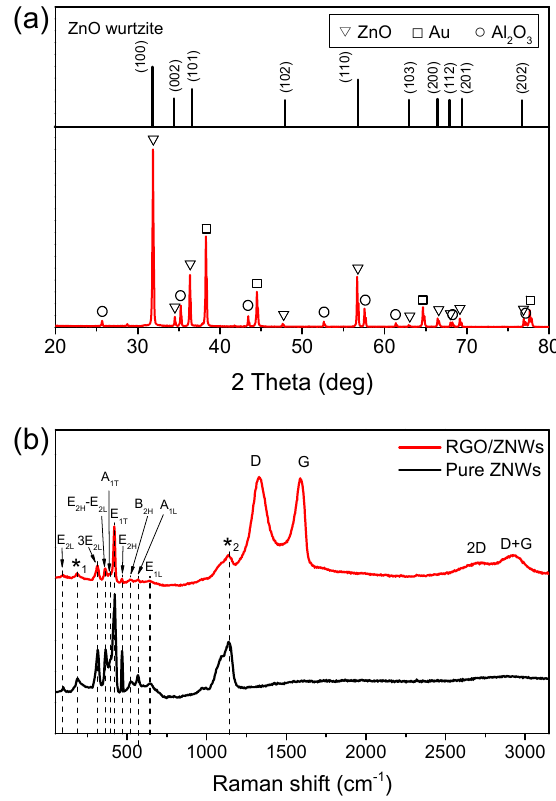
Figure 2. ( a ) X-ray diffraction (XRD) spectrum of ZNWs and ( b ) Raman spectra of pure ZNWs and RGO/ZNWs composite with 1.0 wt % of RGO loaded.